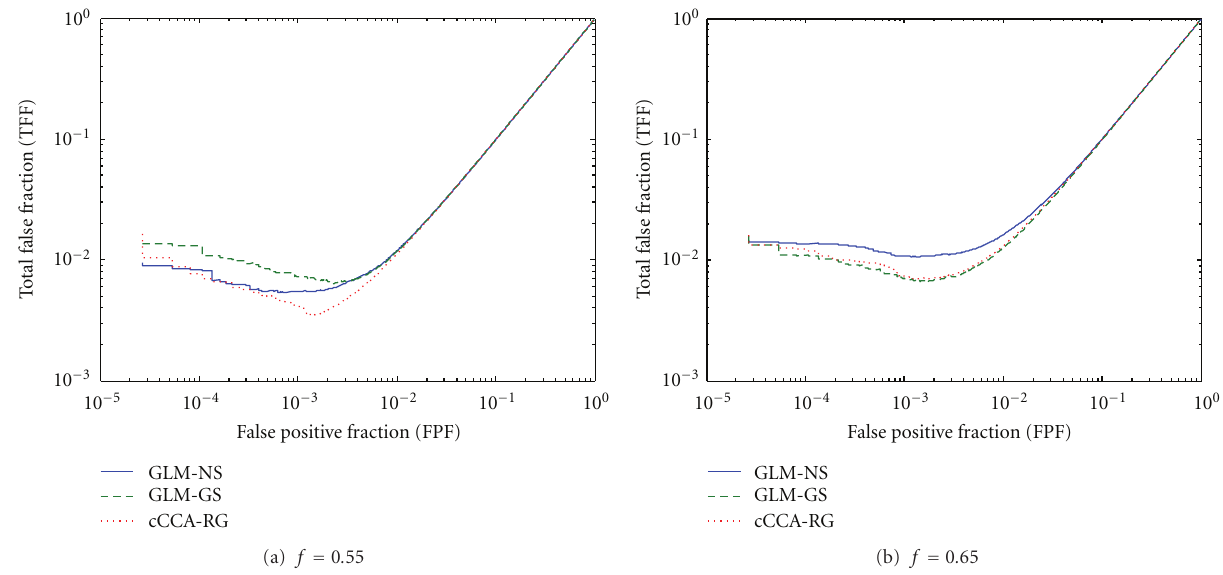
Figure 5: The total false fraction (TFF) (including false positives and false negatives) versus the false positive fraction (FPF) for the contrast V-F of the visual paradigm for pseudoreal data: (a) the low noise case ( f = 0 . 55) and (b) the high noise case ( f = 0 . 65). Note that all TFF curves have minima in the interval [0 . 001,0 . 01]. The cCCA-RG performs nearly optimal in both cases by achieving the minimum value of TFF.